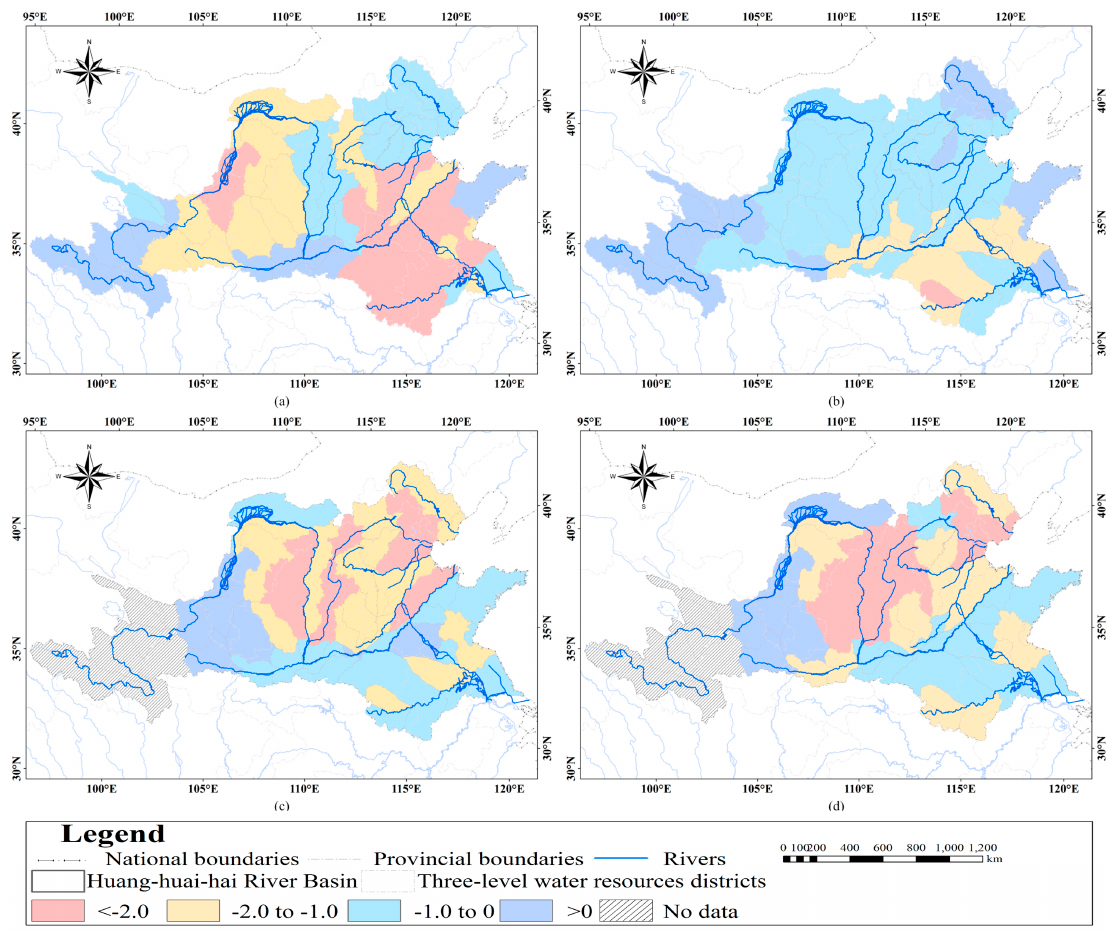
Figure 7. The ratio of drought affected area (RDAA) and the ratio of drought suffering area (RDSA) of meteorological droughts and statistical droughts: ( a ) RDAA of meteorological droughts; ( b ) RDSA of meteorological droughts; ( c ) RDAA of statistical droughts; and ( d ) RDSA of statistical droughts.